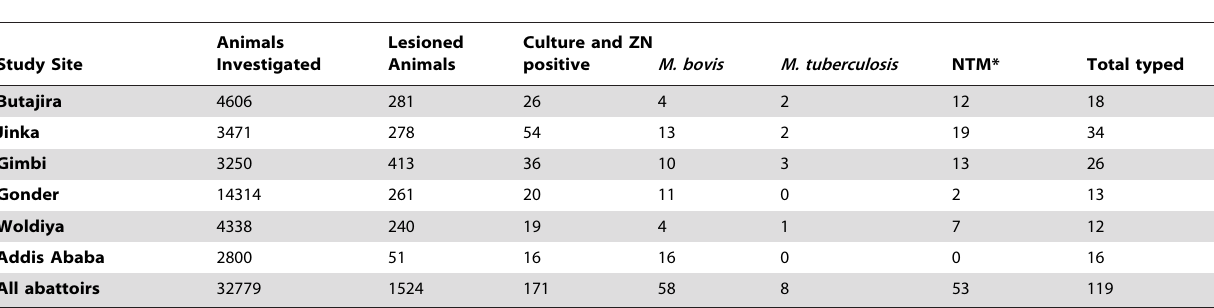
Table 2. Summary of collected lesions and molecular typed AFB isolated from cattle slaughtered at six Ethiopian abattoirs.